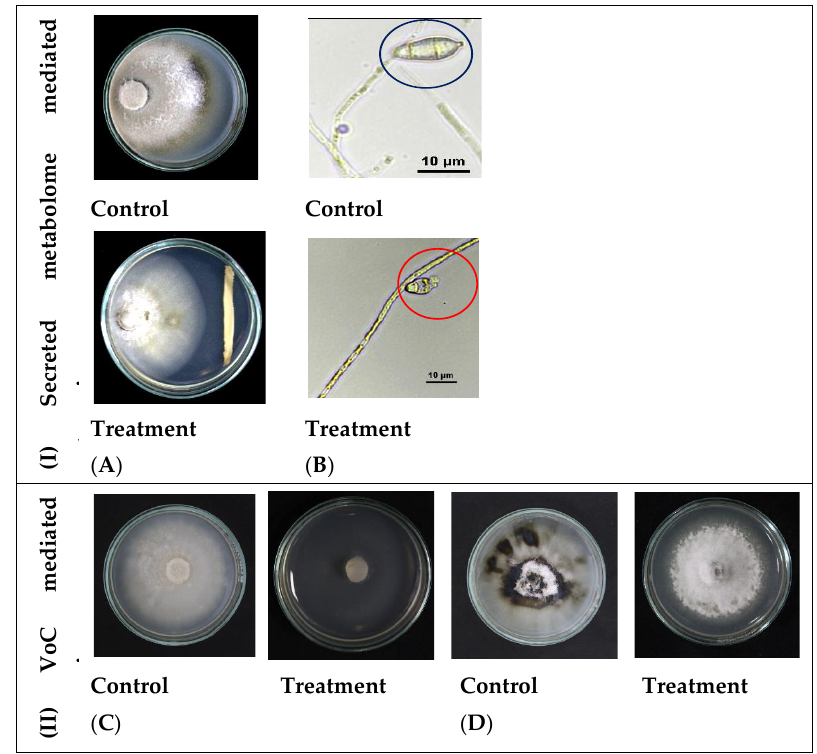
Figure 2. Antagonism of M. testaceum B2 on M. oryzae 1637; (I) Secreted metabolite mediated antagonism; (II) Volatile Compound mediated antagonism. Percent reduction in mycelial growth of Magnaporthe oryzae was observed over control in both secreted metabolite as well as volatile mediated dual culture assays. In addition, conidial morphology deformation was observed in the secreted metabolite-mediated assay ( A ) Secreted metabolites mediated inhibition of M. oryzae -1637. ( B ) Conidial deformation due to bacterial secreted metabolites interaction with fungus (blue circle — healthy conidia; red circle — deformed conidia). ( C ) Volatiles of M. testaceum B2suppressed mycelial growth. ( D ) Volatiles of M. testaceum B2showed fungistasis on mycelial growth.